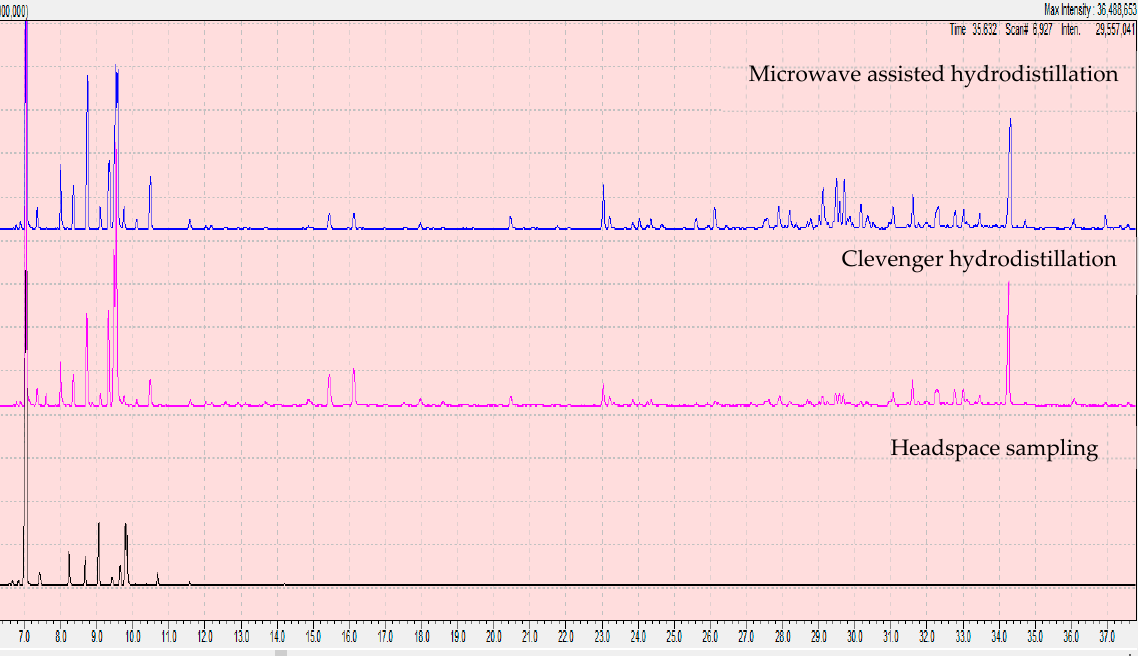
Figure 3. GC-MS chromatograms of leaves (sample code 12) collected in autumn season; blue and pink chromatograms denote essential oils extracted by microwave and Clevenger hydrodistillation, respectively, while black represents the headspace-GC-MS chromatogram.